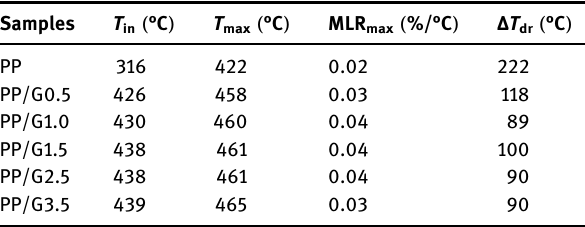
Table 5: TGA test parameters of neat PP and PP/GNP nanocomposites